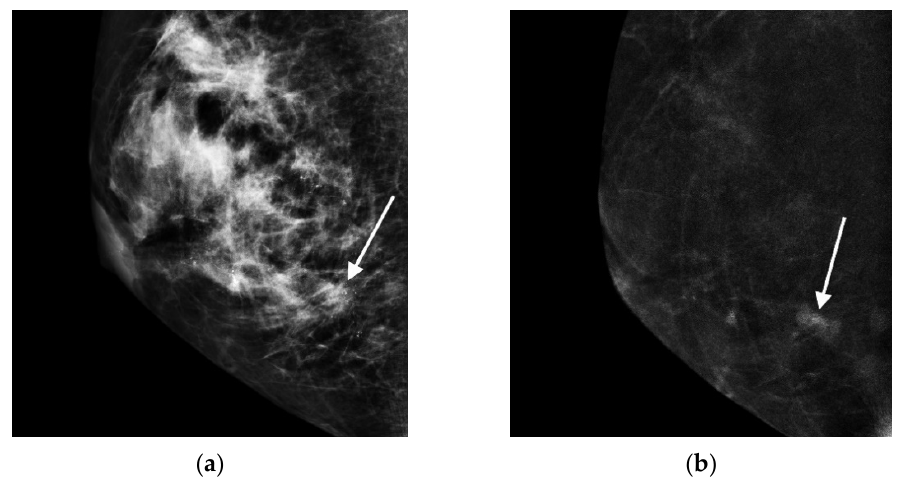
Figure 2. Mass with unpurified ground glass enhancement: In a 57-year-old woman, the biopsied microcalcifications were a group of pleomorphous microcalcifications (arrow) in the lower region of the right breast on LM in MLO view ( a ). REI revealed an associated irregular mass with ground glass and solid enhancement (arrow) ( b ). Finally, it was surgically proven to be IDC.